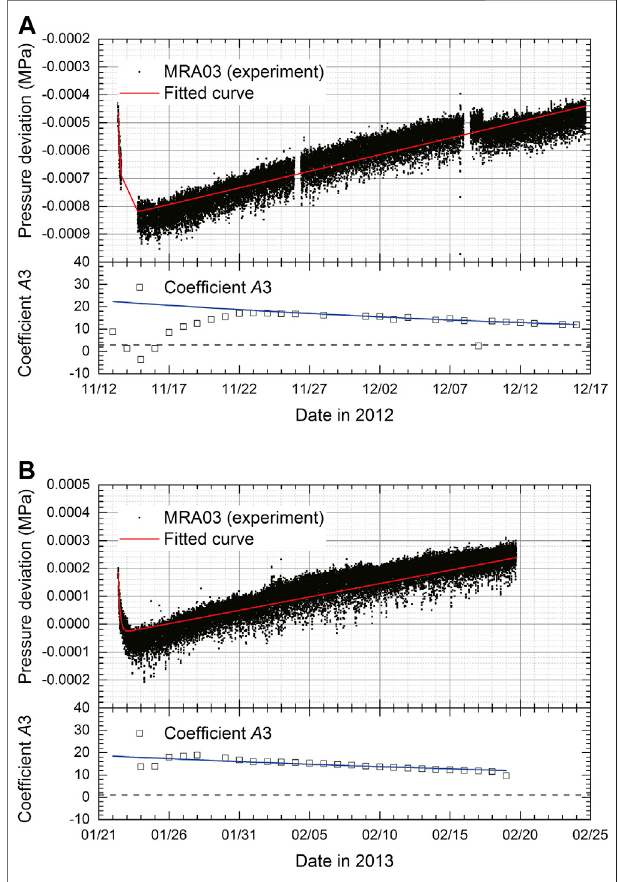
FIGURE 10 | (A) Deviation from the pressure standard (reference pressure) oftheMRA03pressuresensor (top) andvariationofcoef fi cient A 3 during the experiment (bottom) . The unit is Pa/day. The blue and dashed lines represent the exponential approximation of coef fi cient A 3 and its limitvalue,respectively. (B) Theexperimentin2013ispresentedinthesame form as (A)